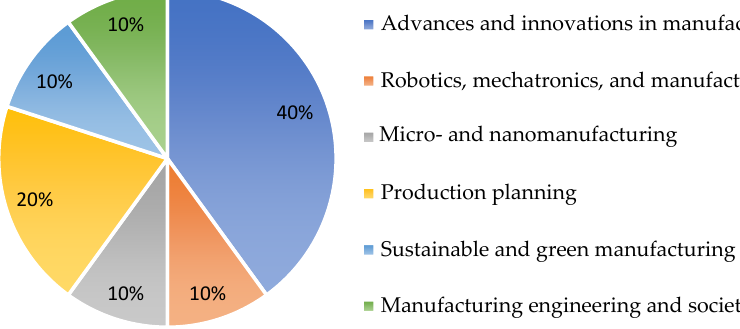
Figure 1. Contribution (%) of each topic to the total of the joint Special Issue.